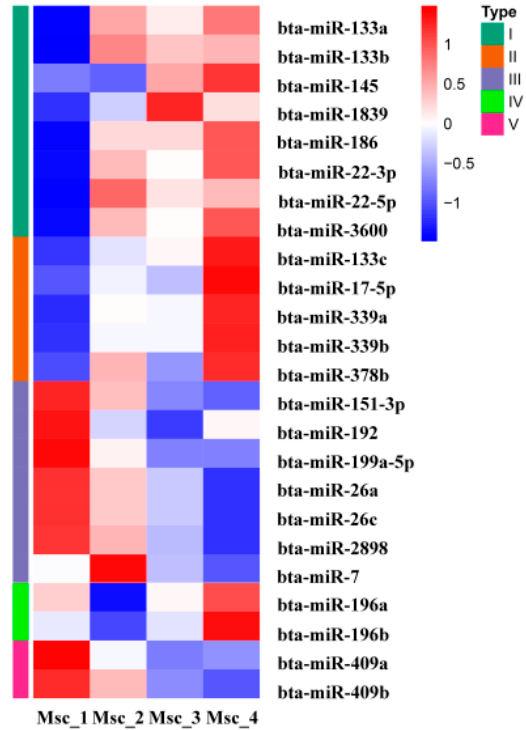
Figure 3. Hierarchical clustering of DE miRNAs.